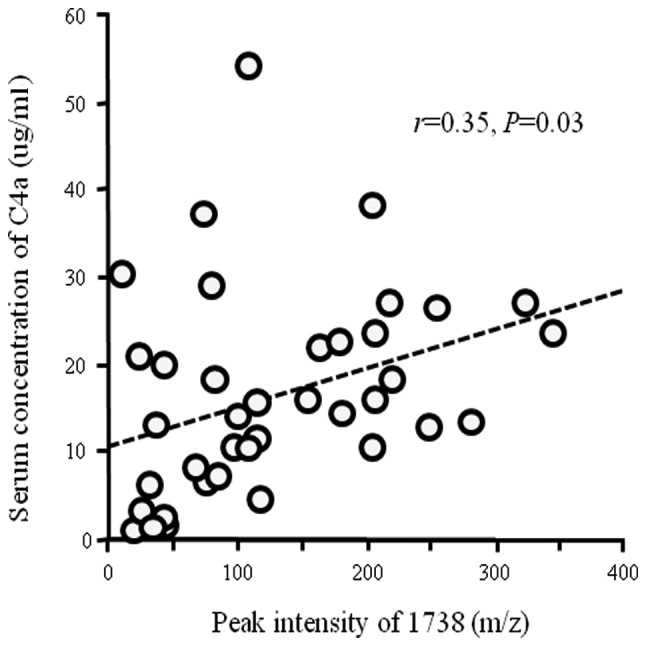
Association between the peak intensity of 1738 m/z (C4 fragment) and the serum level of C4a as determined by enzyme-linked immunosorbent assay. The peak intensity of 1738 m/z correlated with serum C4a levels (r=0.35, P=0.03). C4a, complement component 4a.